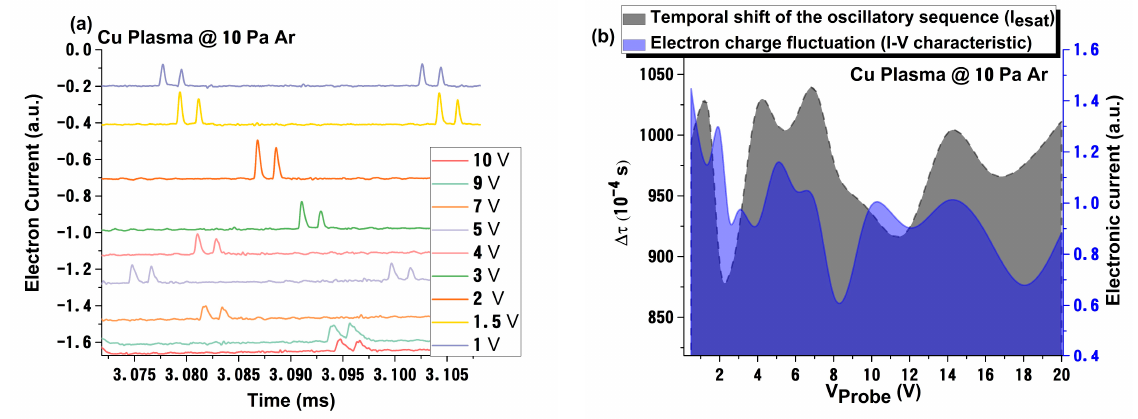
Figure 2. Oscillatory signal variation with the applied ( a ) and probe bias variations of the oscillation shift and overall electronic charge ( b ).